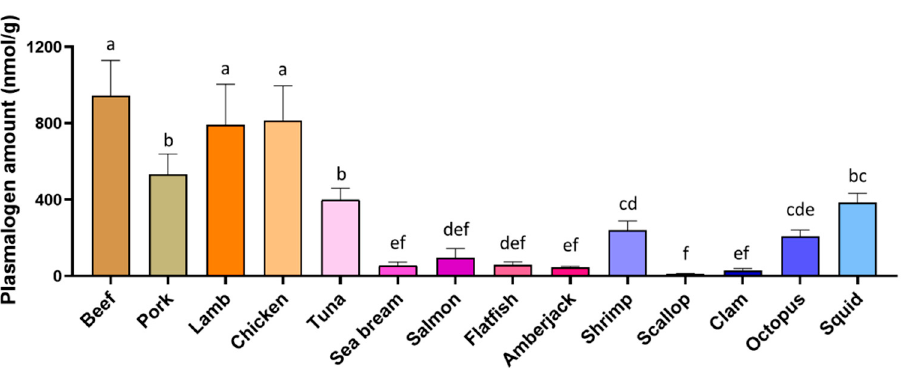
Figure 3. Comparison of total plasmalogen amount in foodstuffs. a–f, bars with different letters differ at p < 0.05, calculated by one-way ANOVA with the Tukey ′ s post hoc test. Data were expressed as means ± SD.